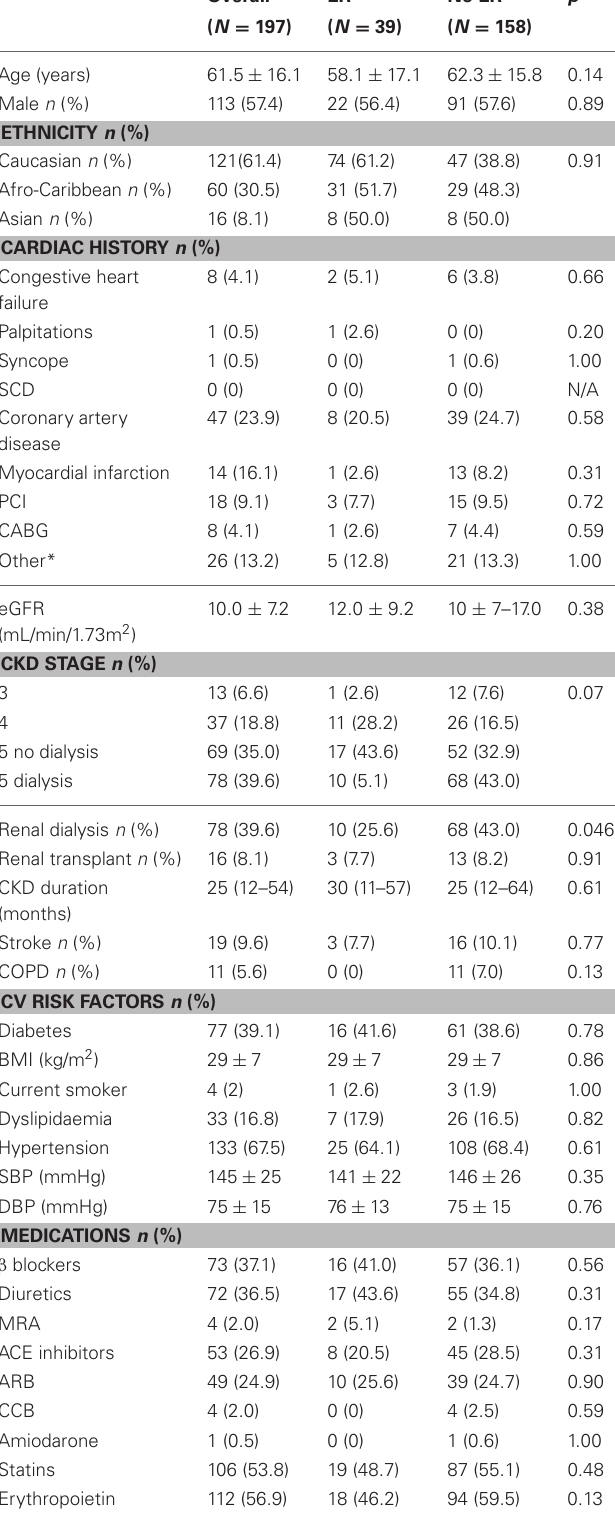
Table 2 | Comparison of baseline characteristics of patients with CKD vs. the renal transplant donors.